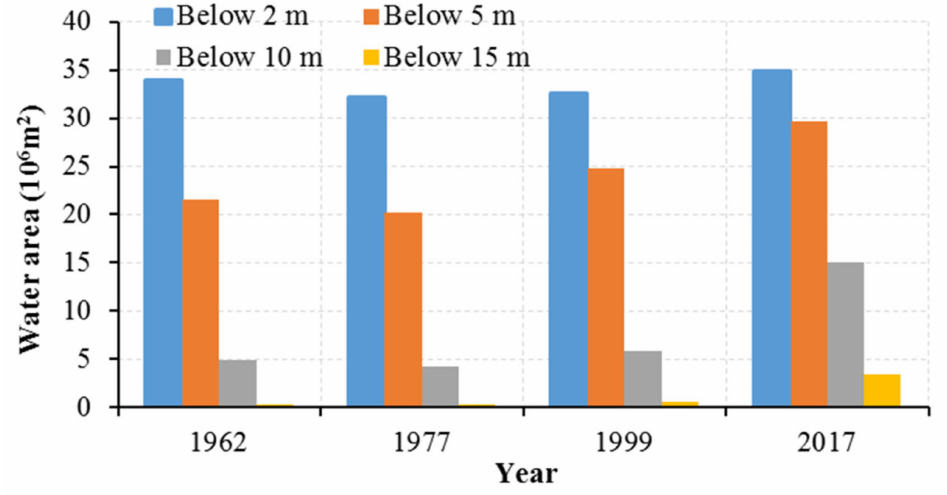
Figure 4. Changes in water area below the 2 m, 5 m, 10 m, and 15 m isobaths from 1962 to